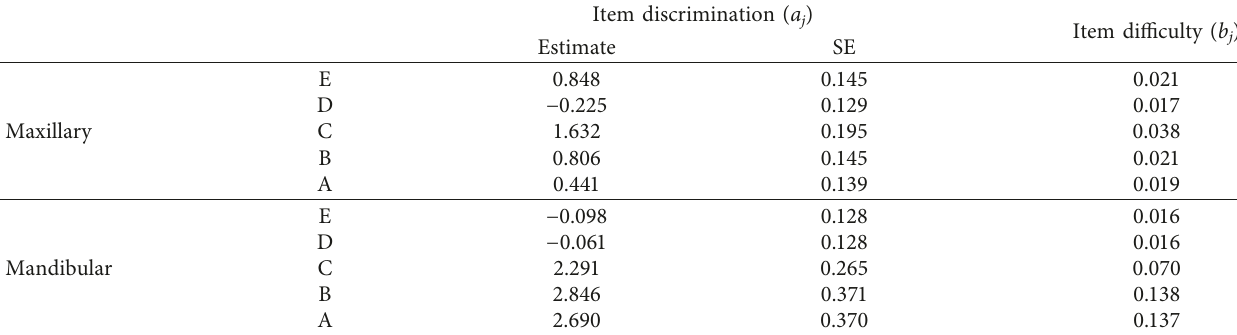
Table 3: Sensitivity of dental caries of deciduous teeth by item response theory (IRT) analysis.